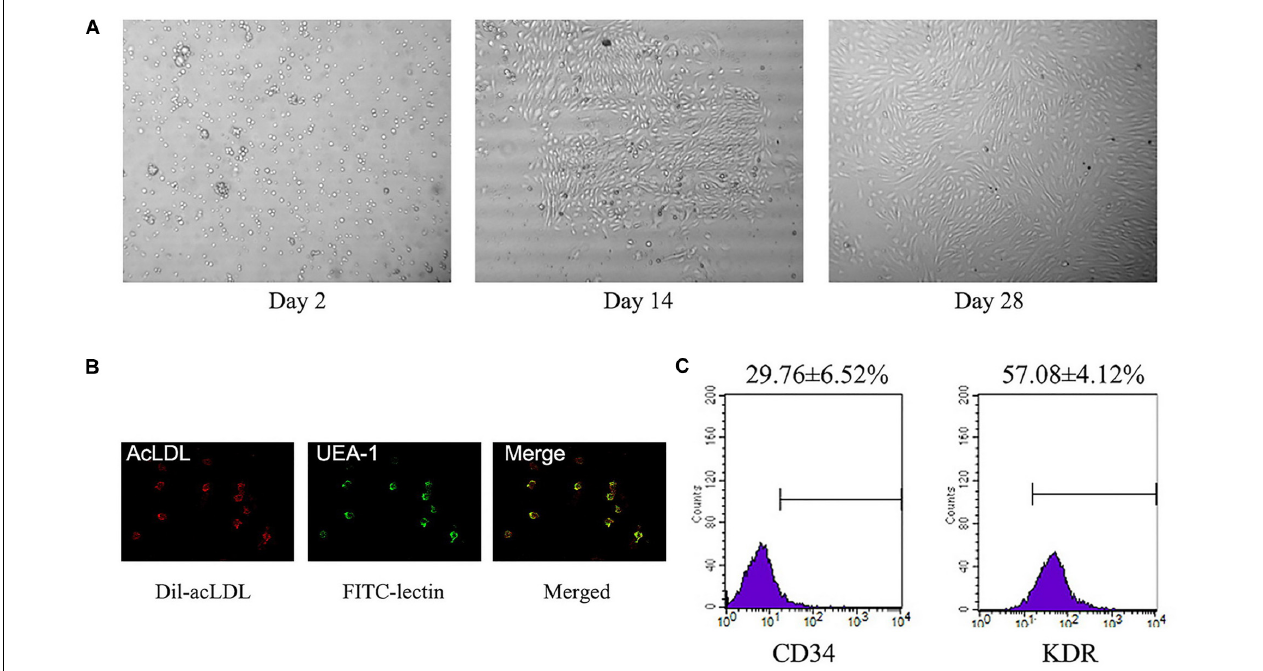
FIGURE 2 | Identification of L-EPCs. (A) The panel shows the sequential changes of L-EPCs. All the pictures were taken under × 100 magnification. (B) The L-EPCs shows both Dil-uptaken (red) and lectin binding (green) ability ( × 400 magnification). (C) Flow-cytometry reveals the L-EPCs expressed abundant CD34 and KDR molecule. Numbers are presented as Mean ± SEM. Percentage of positive cells for all experiment is determined by comparison with corresponding negative control